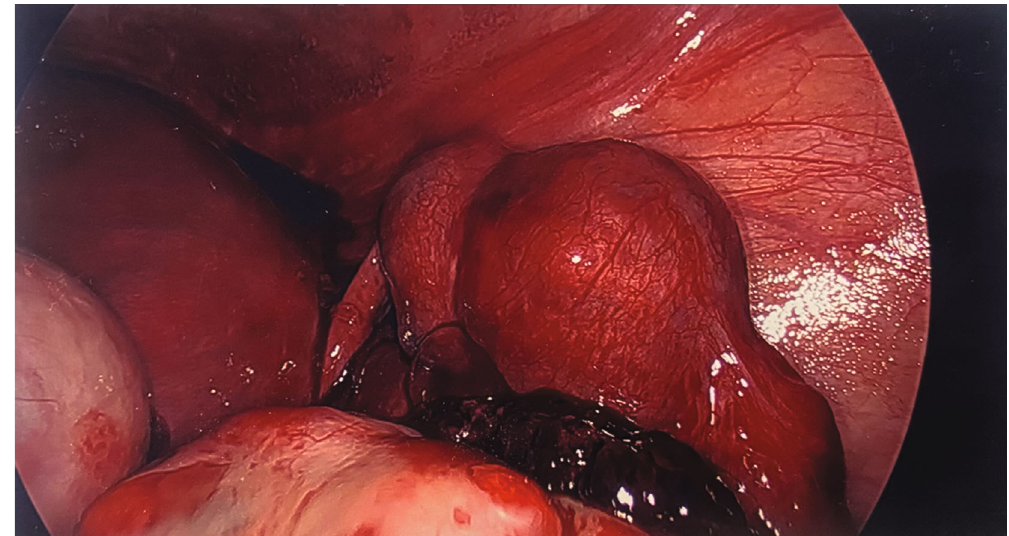
Figure 4: Intraoperative laparoscopic fi ndings of bilateral tubal masses with gravid